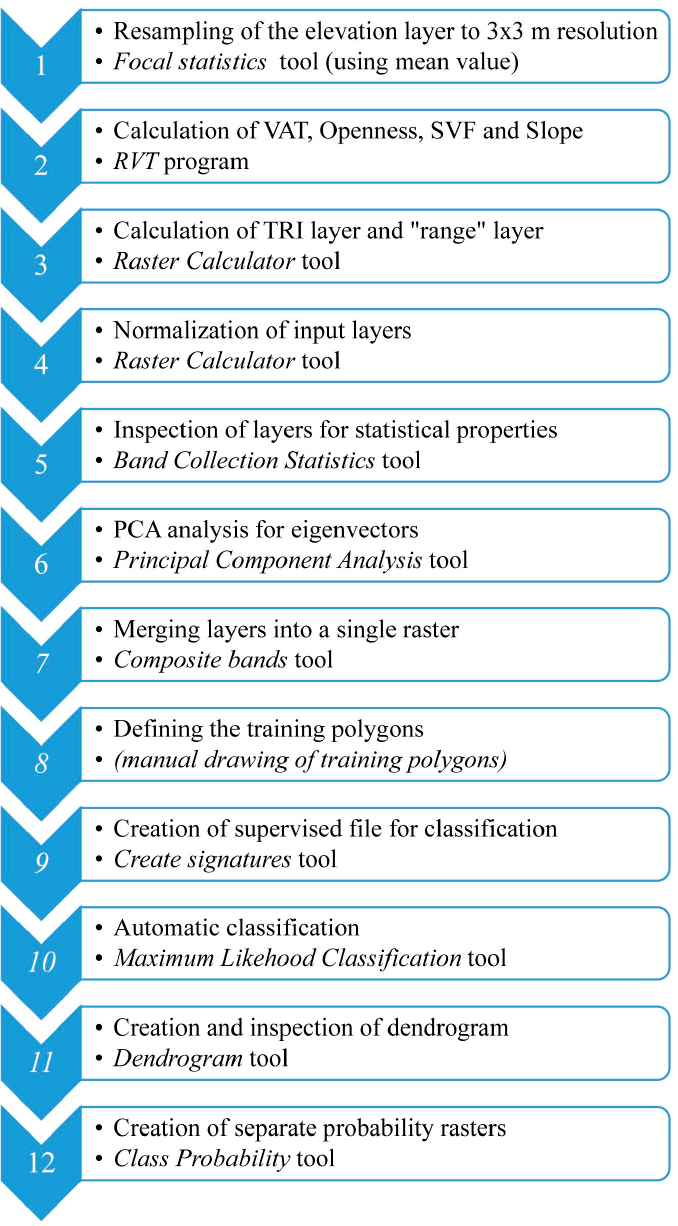
Figure 2. Workflow process for the automatic supervised classification. The first line denotes the description and purpose of the tool, and the second line includes the name of the tool used in ArcGIS.